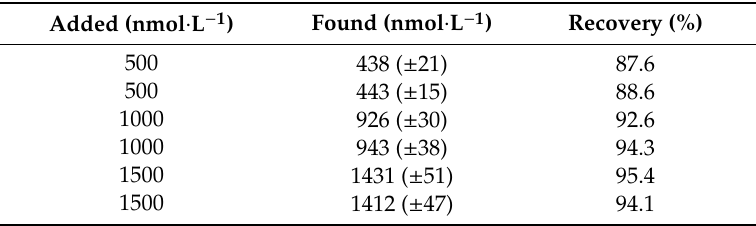
Table 4. Accuracy of the developed method.